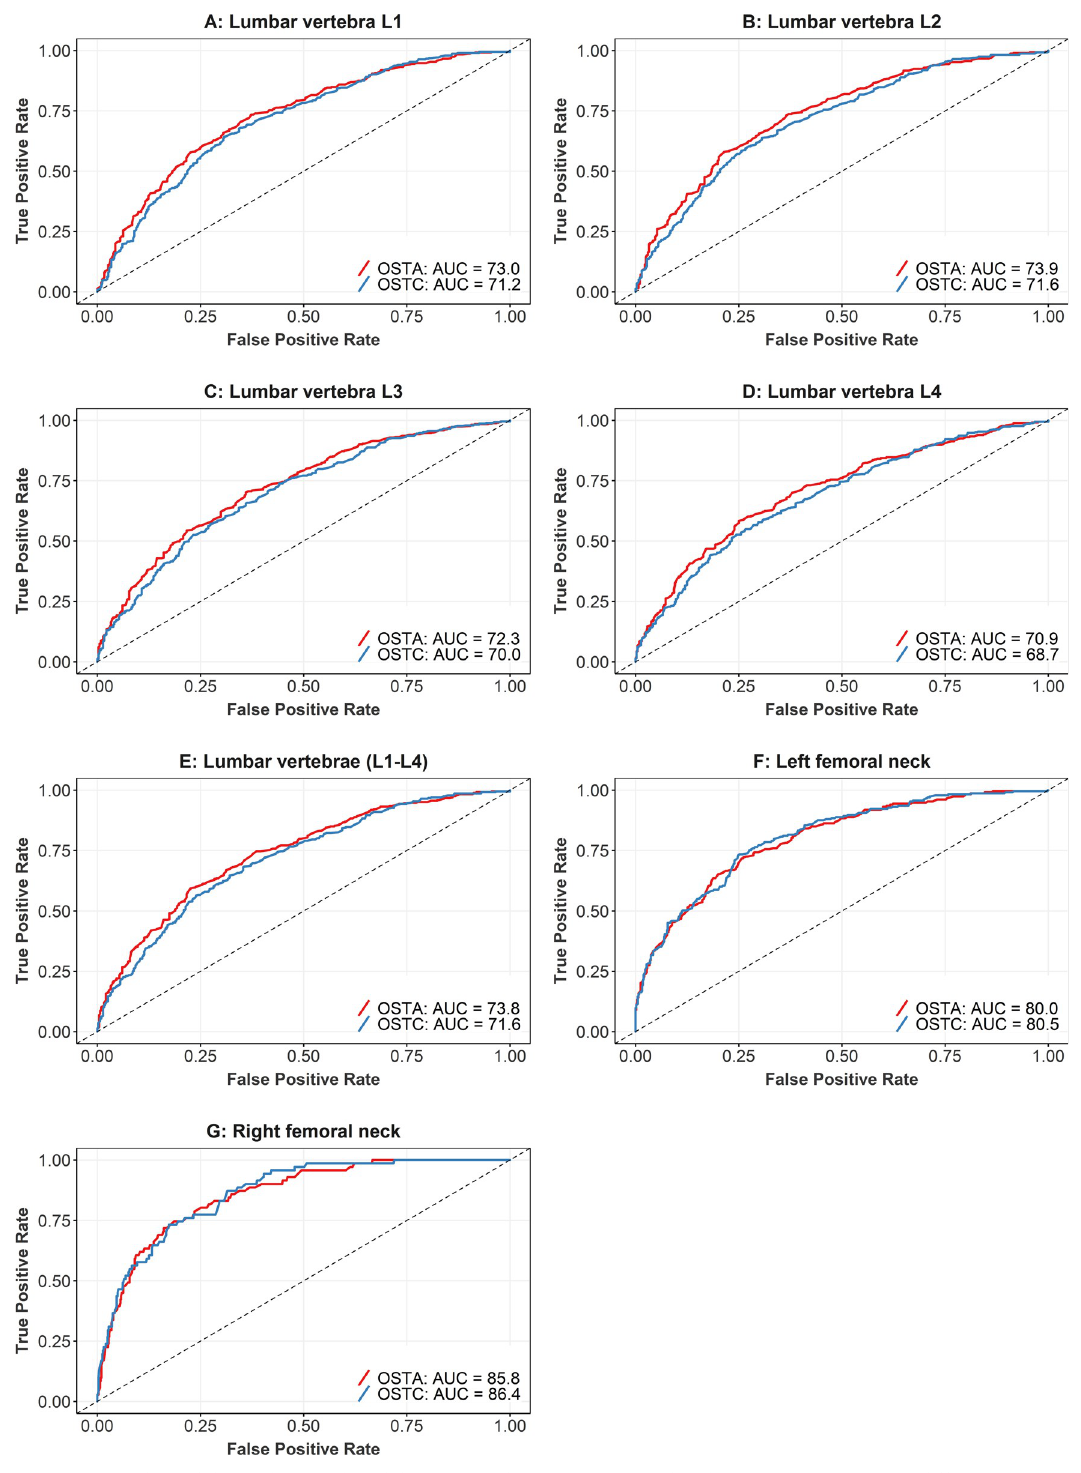
Fig 2. ROC analysis of the predictive value of the OSTA and OSTC as compared to the BMD measurement in different anatomical sites.